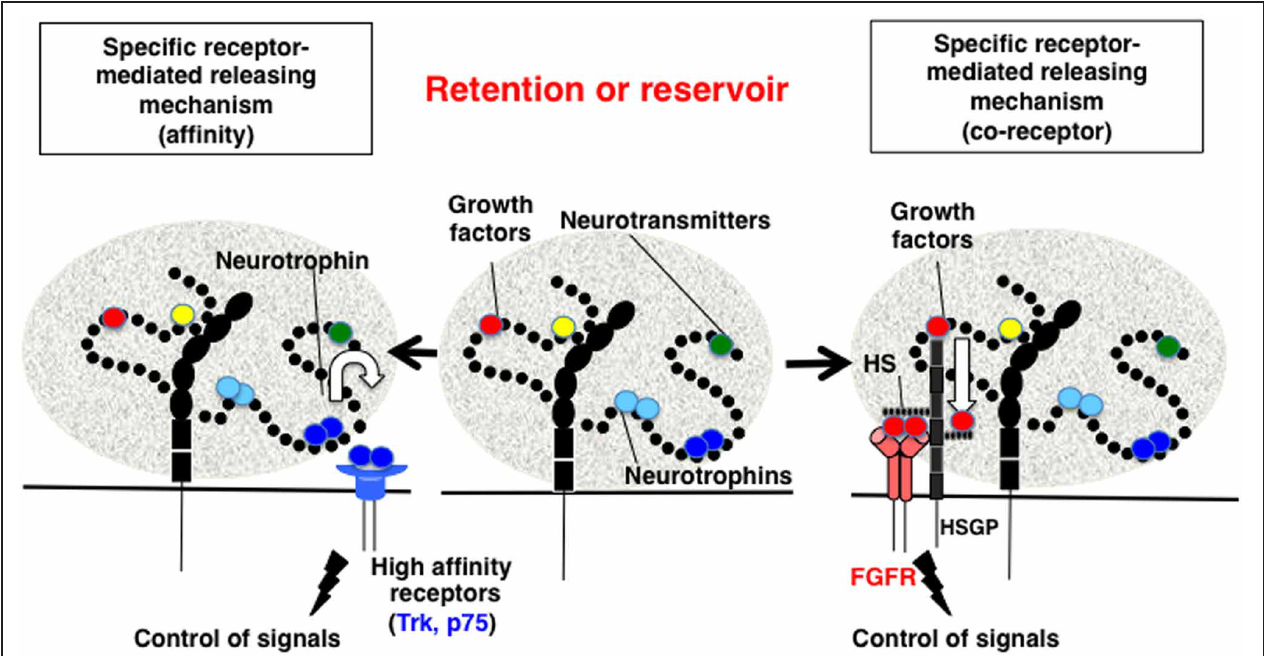
receptors, and polySia. Right panel , Specific receptor-mediated release mechanism-1 (Co-receptor). In the case of fibroblast growth factor 2 (FGF2), polySia does not release FGF2 from the FGF2-polySia complex to the FGF receptor (FGFR). Notably, FGF2 in the FGF2-polySia complex can migrate to heparan sulfate (HS) to form a FGF2-HS complex, which can then bind to FGFR as a ternary complex to enhance FGF signaling. Therefore, polySia regulates FGF2 signaling by passing FGF2 to HS and finally to